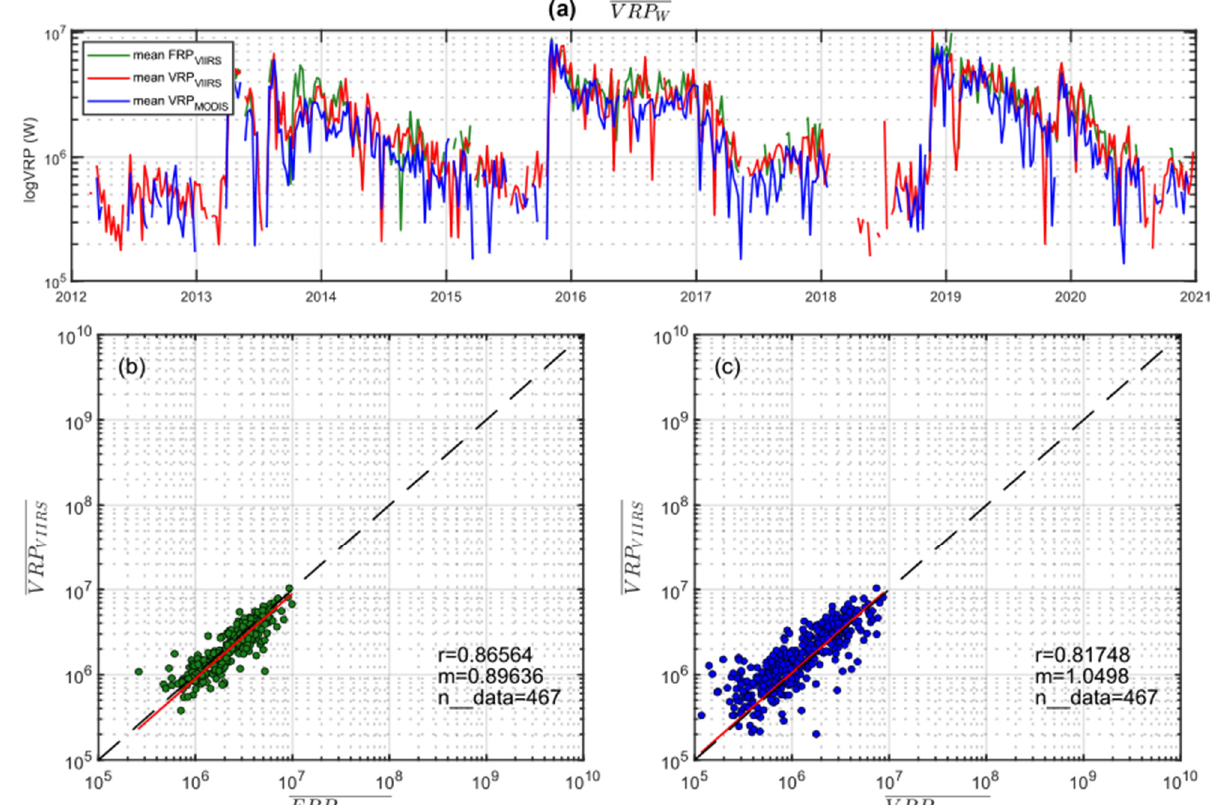
Figure 6. ( a ) Stacked time series of VRPw (weekly mean) retrieved for MIROVA VIIRS (red), MIROVA MODIS (blue), and FIRMS VIIRS (green) at Láscar volcano in logarithmic scale. ( b , c ) Linear regression analyses between the weekly means of VRP VIIRS and FRP VIIRS (green), and VRP VIIRS and VRP MODIS (blue) at Láscar, respectively. The best-fit coefficient (m) close to 1 and the Pearson correlation coefficient r equal to 0.87 and 0.82, respectively, indicate an excellent correlation between the time series retrieved by MIROVA and FIRMS algorithms. Table 2. Comparison between the datasets MIROVA VIIRS , MIROVA MODIS and FIRMS VIIRS for Láscar and Erta Ale volcanoes. The summary includes the number of overpasses (N pass ), the number of alerts (N alerts ) including the frequency (f%) of alerts (N alert /N pass ), the N alert ratio (ratio between the number of alerts detected by the different algorithms) as well as the mean and maximum VRP/FRP obtained for each dataset.